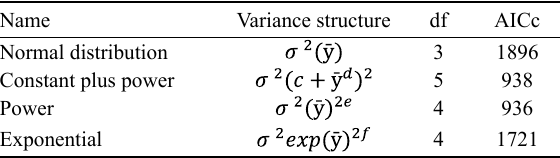
3. – Variance structure, degree of freedom (df) and small-sample bias-corrected form of the Akaike information criterion (AICc) for each of the four generalized non-linear models constructed using M - L data. The best model was selected considering the F